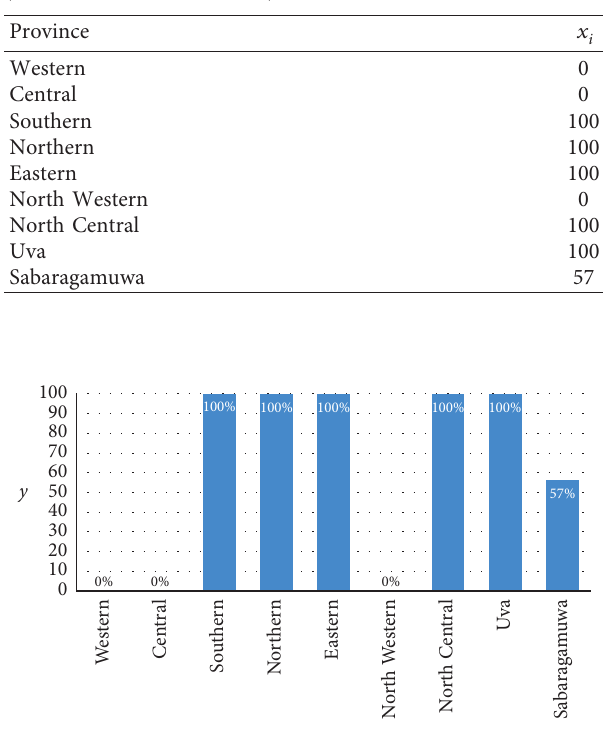
Table 2: Optimal lockdown relaxations of provinces as percentages (number of ICU beds � 1000).